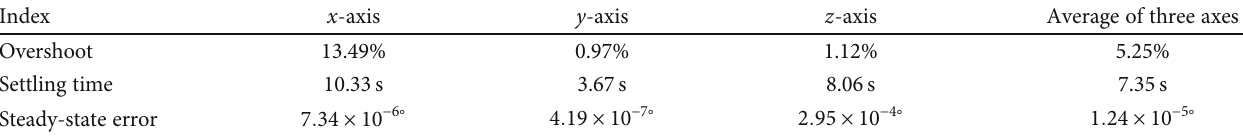
Table 10: Average step response performance of the PID controller for all the ground targets.